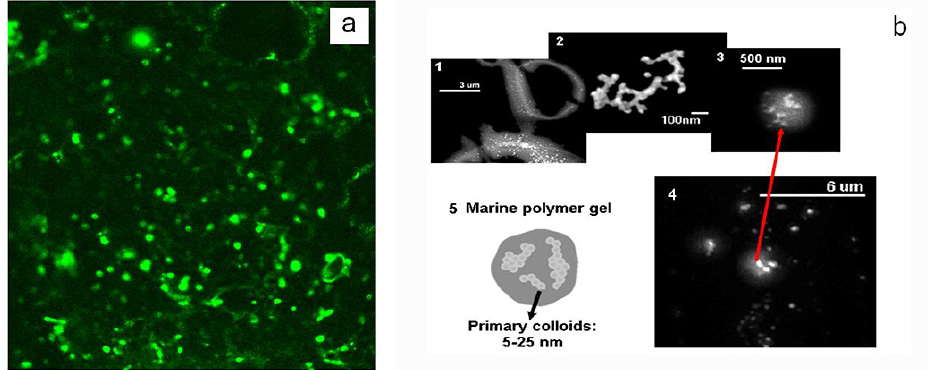
Fig. 14. (a) Marine polymer gels in cloud water immunostained with a specific antibody developed towards polymeric material collected in surface microlayer and subsurface waters. (b) Structure of polymer gels showing the following: (b1) low water-soluble organic particles in the surface microlayer present large quantities of colloidal-size nanogels (<1µm diameter), which assembled into larger than 3µm diameter microgels; (b2) colloidal-size nanogels measured by FESEM microscopy tend to present fractal structures in sizes generally under 200nm diameter and always smaller than 1µm in both surface microlayer and cloud samples; (b3 and b4) the gels in the cloud samples present average sizes between 200 and 700nm, with colloidal-size nanogels partitioned inside of the polymer gels; (b5) the schematic illustration shows that colloidal-size nanogels tend to present a fractal structure of the larger microgels. Figure is adapted from Orellana et al.